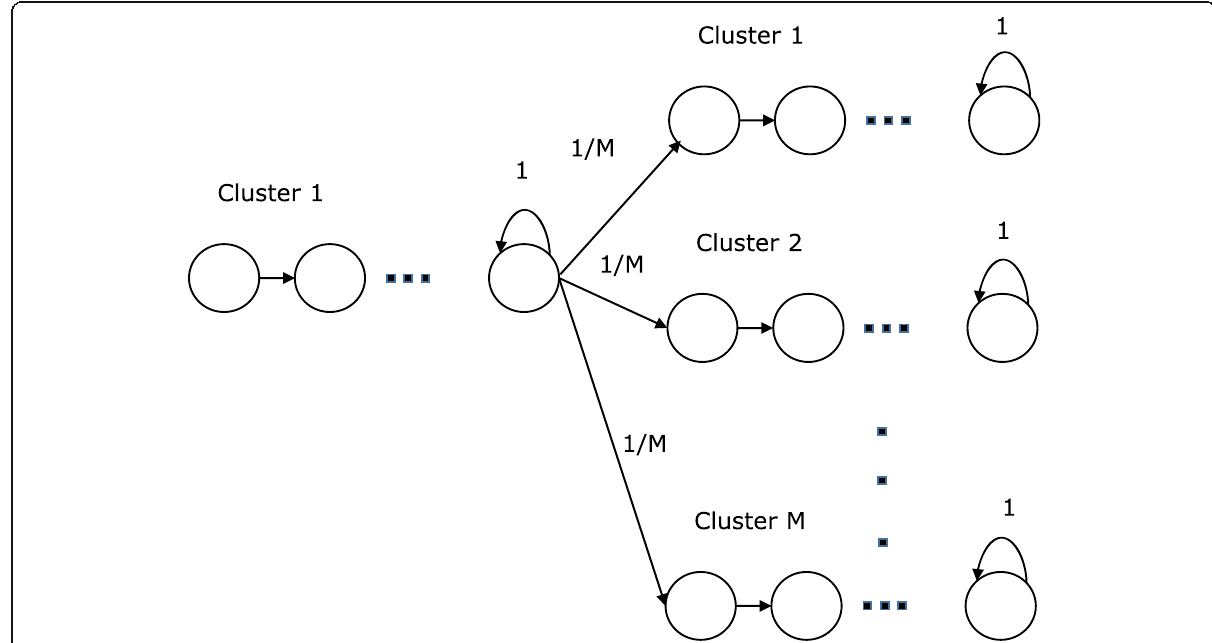
Fig. 4 Diagram of the dependency of turn speaker changes with the number of active